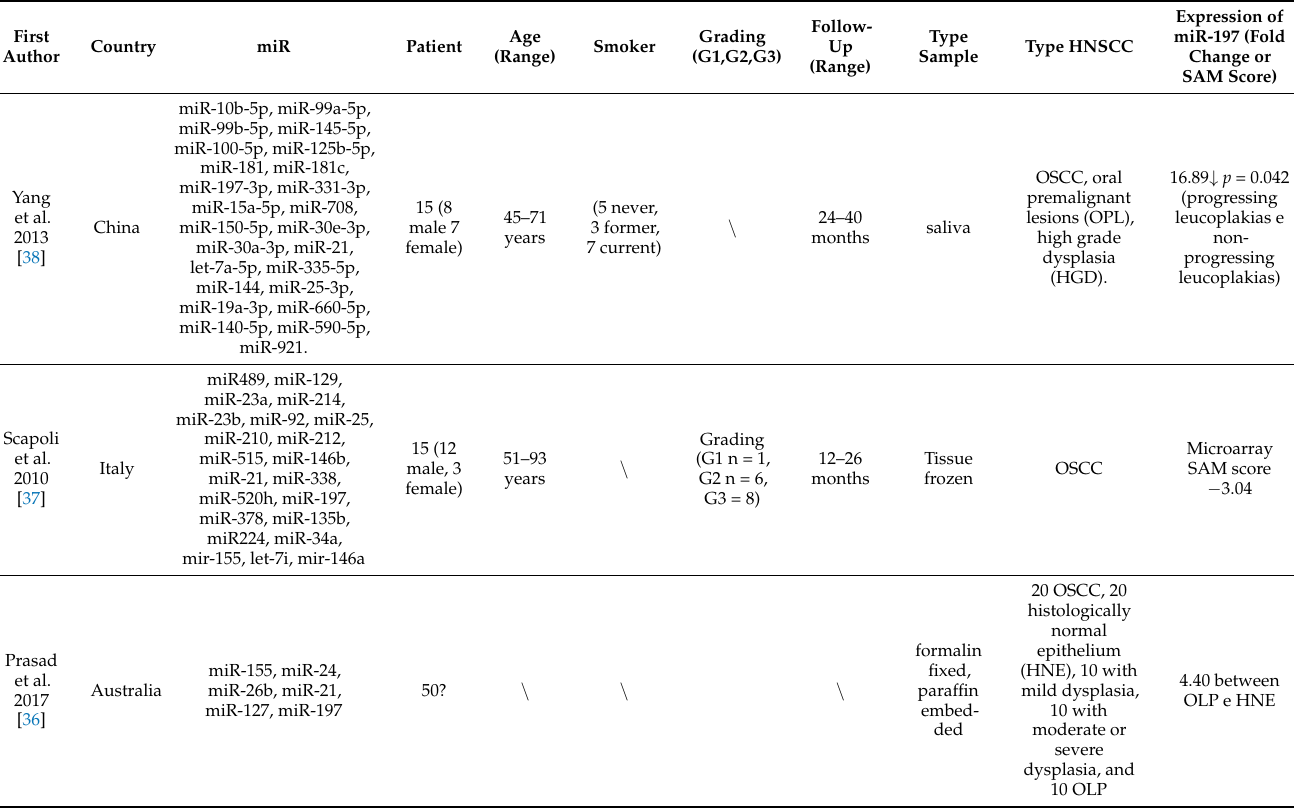
Table 2. The data extracted for the study included in the secondary